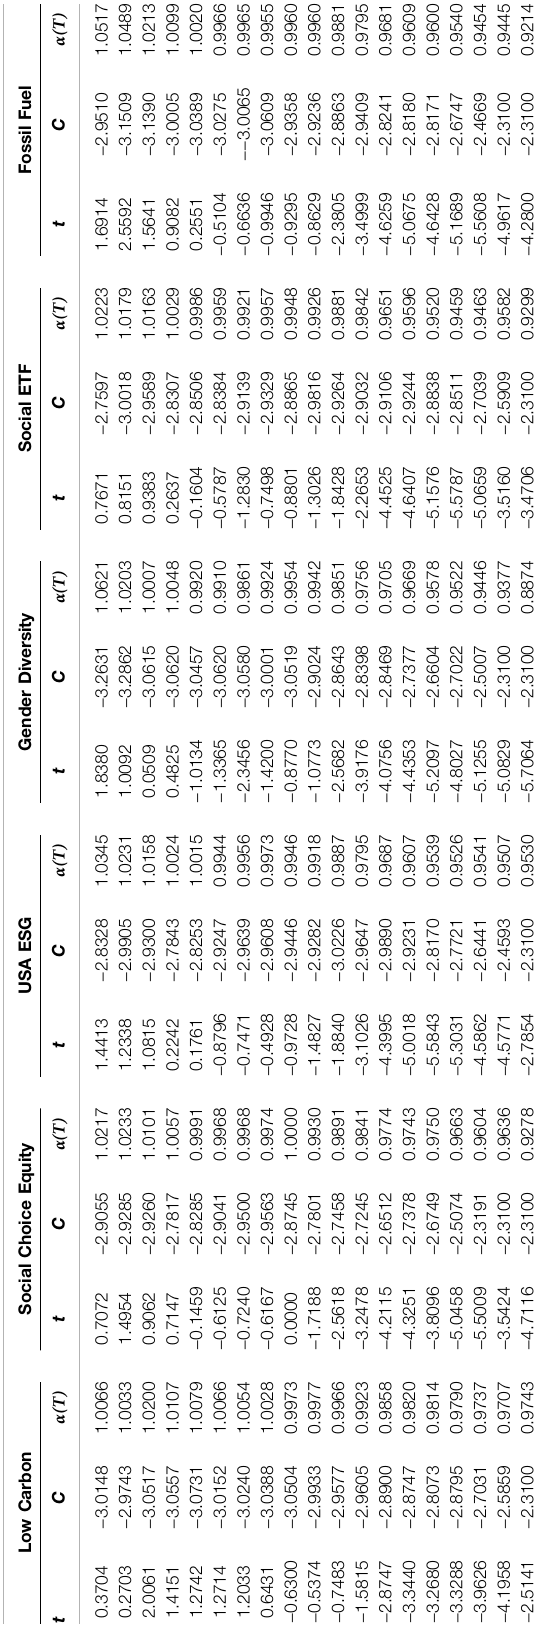
Figure 3B re fl ects the correlation pattern under different quantile distributions for the medium-run investment